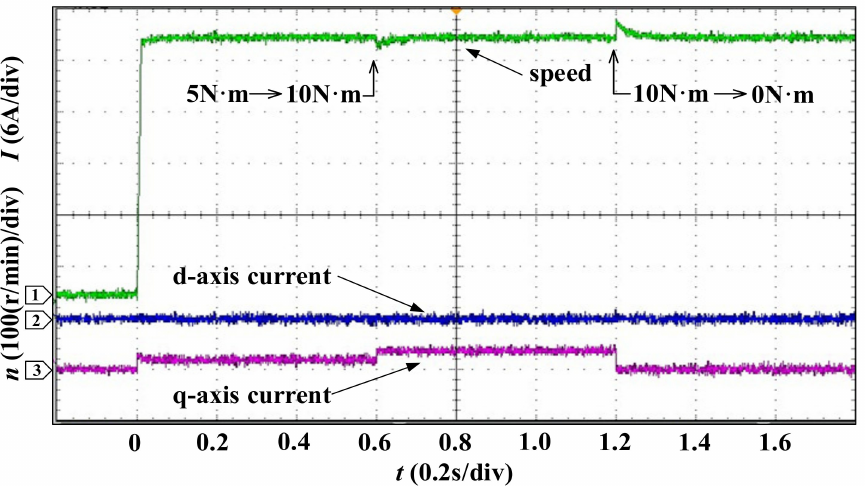
Figure 9. Experimental results of motor load variation based on singular perturbation second-order sliding mode control